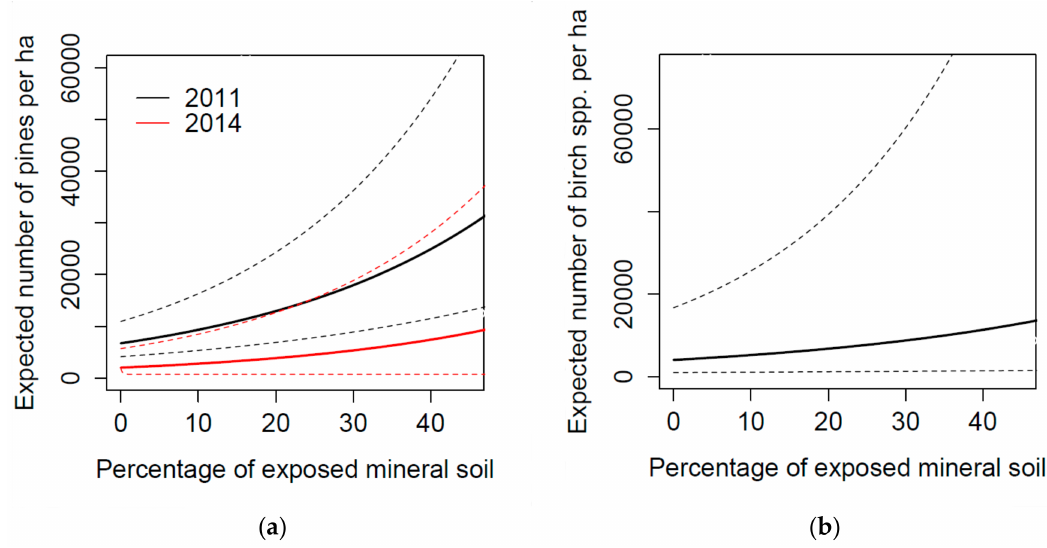
Figure 1. Predicted model for expected density of ( a ) Scots pine seedlings and ( b ) birch seedlings (downy birch and silver birch combined) with increasing proportion of exposed mineral soil, and an average level of 8.7% “other cover”. For pine, expected density is shown for stands scarified in 2011 (black solid line) and stands scarified in 2014 (red solid line). The dotted lines illustrate the 95% confidence intervals. Prediction lines for stands scarified in 2012/2013 were not included in this figure in order to maintain readability. For birch, scarification year was not included in the best model, and is therefore not included in the